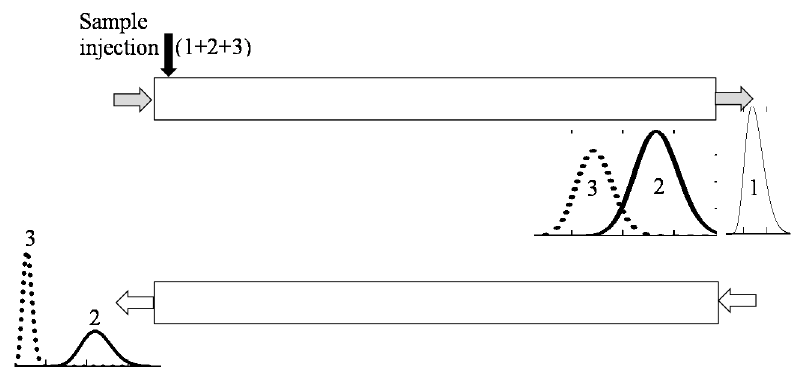
Figure 2. Schematic diagram of the MDM CCC separation with variable duration of phase elution steps: individual solutes are completely removed from the column with different phase flows.